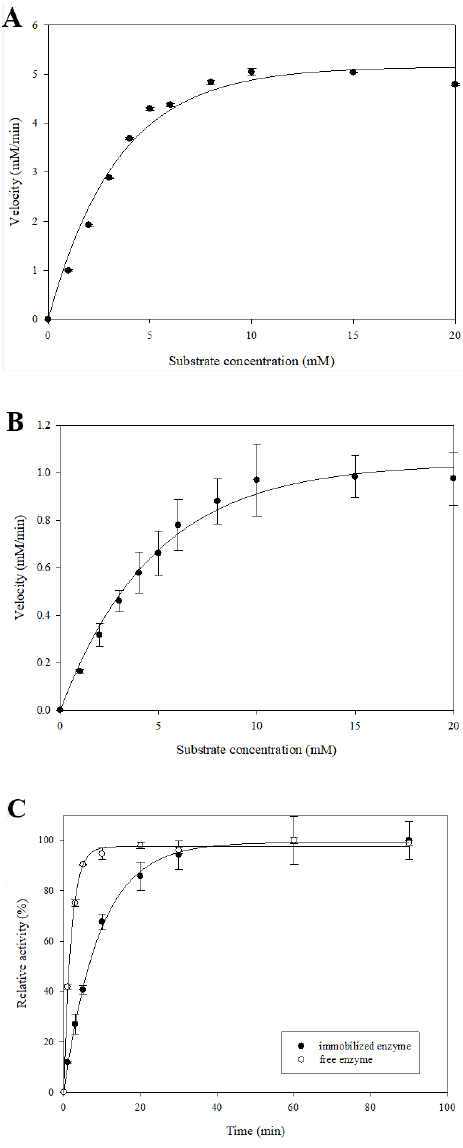
Figure 3. Effects of p ‐ NPG concentration on the activity of free β‐ glucosidase ( A ) and immobilized β‐ glucosidase ( B ), and effects of time on the activity of free enzyme and immobilized β‐ glucosidase ( C ). Each value is expressed as mean ±SD, and values marked by different letters are significantly different by LSD tests ( p < 0.05). Table 1. Enzyme kinetic parameters of free and immobilized β